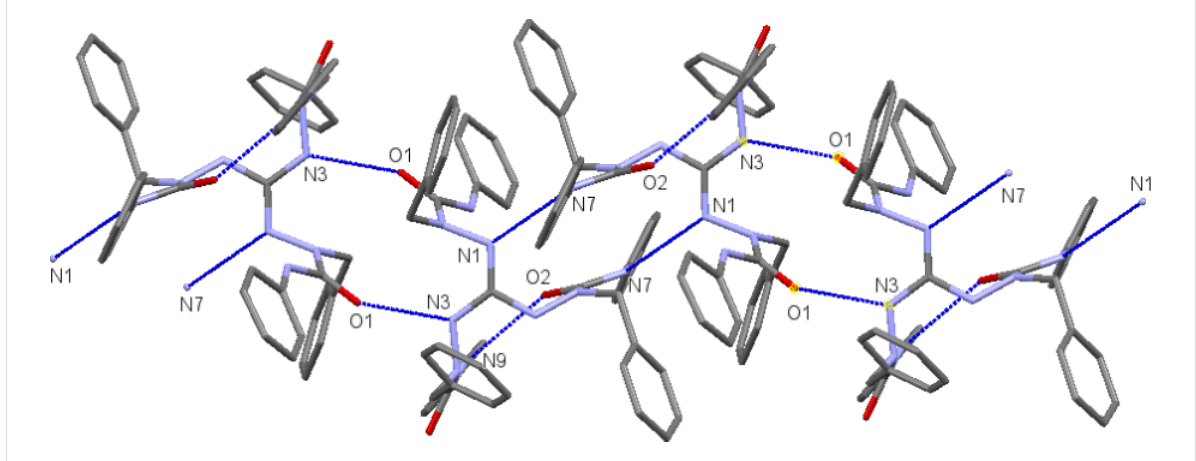
Figure 3: Hydrogen-bonded one-dimensional network of guanidine 8 in the solid state. The intramolecular N9···O2 hydrogen bond is also shown.